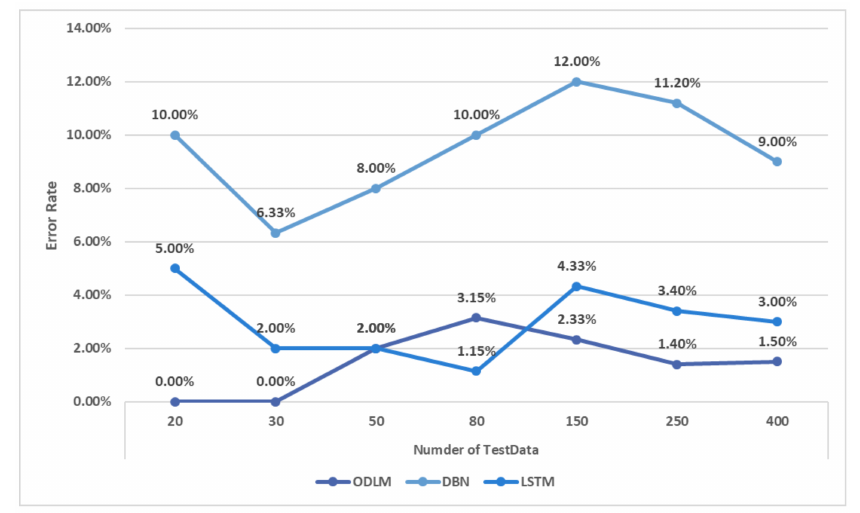
Figure 14. The error rate comparison of diagnosis according to the number of Training Data